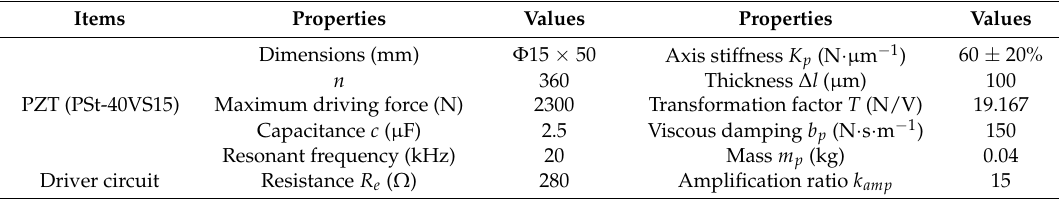
Table 2. Specifications of the piezoelectric actuator and the drive